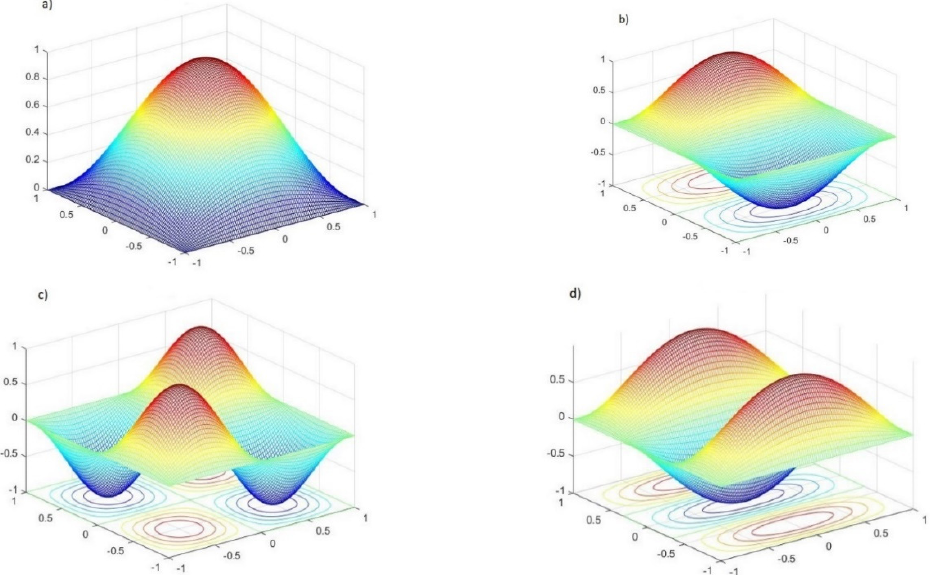
Figure 10. Vibrational modes for SFG distribution without the agglomeration effect: ( a ) 1st mode, ( b ) 2nd mode, ( c ) 4th mode, ( d ) 5th mode.